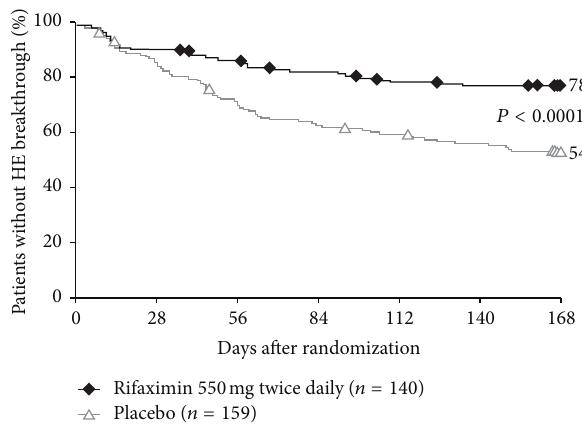
Figure 4: Kaplan-Meier estimate of time to first breakthrough HE episode (primary endpoint) in patients in remission for overt HE (Conn score, 0 or 1). HE breakthrough was defined as an increase in Conn score to ≥ 2 or, if baseline Conn = 0 , a 1-unit increase each in Conn score and asterixis grade. Symbols indicate censored